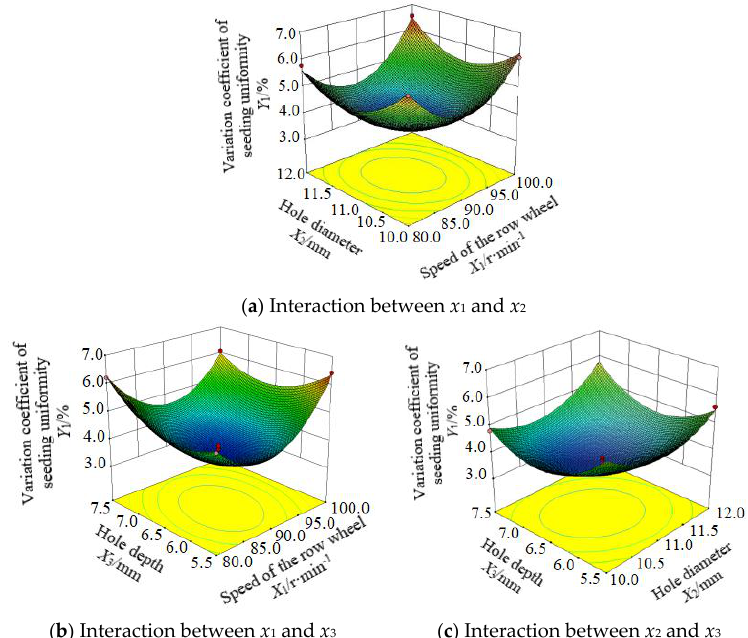
Figure 13. Response surface of the interaction of factors on the variation coefficient of seeding uni- formity. (2) Effect of interaction on the coefficient of variation for consistency of seed quantity in each row Figure 14a is the effect of the interaction between hole diameter x 2 and the rotation speed x 1 on the coefficient of variation for consistency of seed quantity in each row. When the rotational speed of the metering wheel x 1 is constant, each row’s coefficient of di s- placement consistency coefficient increases with the increase in hole diameter x 2 . When the hole diameter x 2 is constant, the displacement coefficient of variation for consistency of seed quantity in each row decreases first and then increases with the rise of the rotation speed x 1 of the metering wheel.